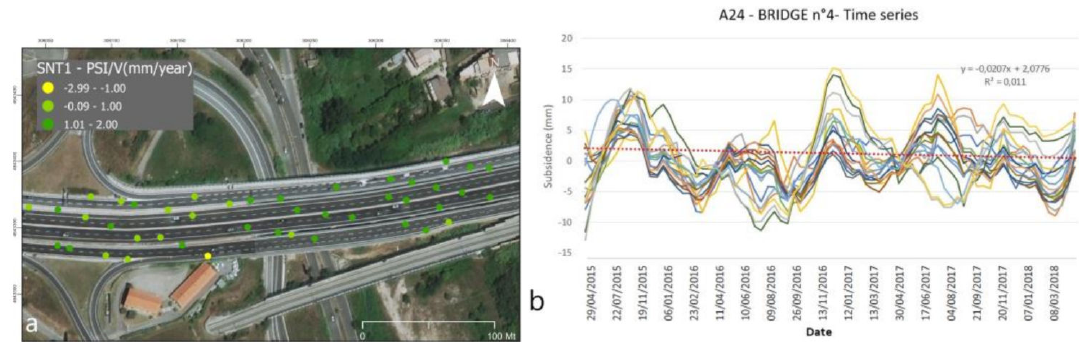
Figure 11. ( a ) Displacement map PSI Sentinel-1, A24 bridge-highway. As background orthophoto Rome, ( b ) Graph of the time series of bridge with structural bridge stability.